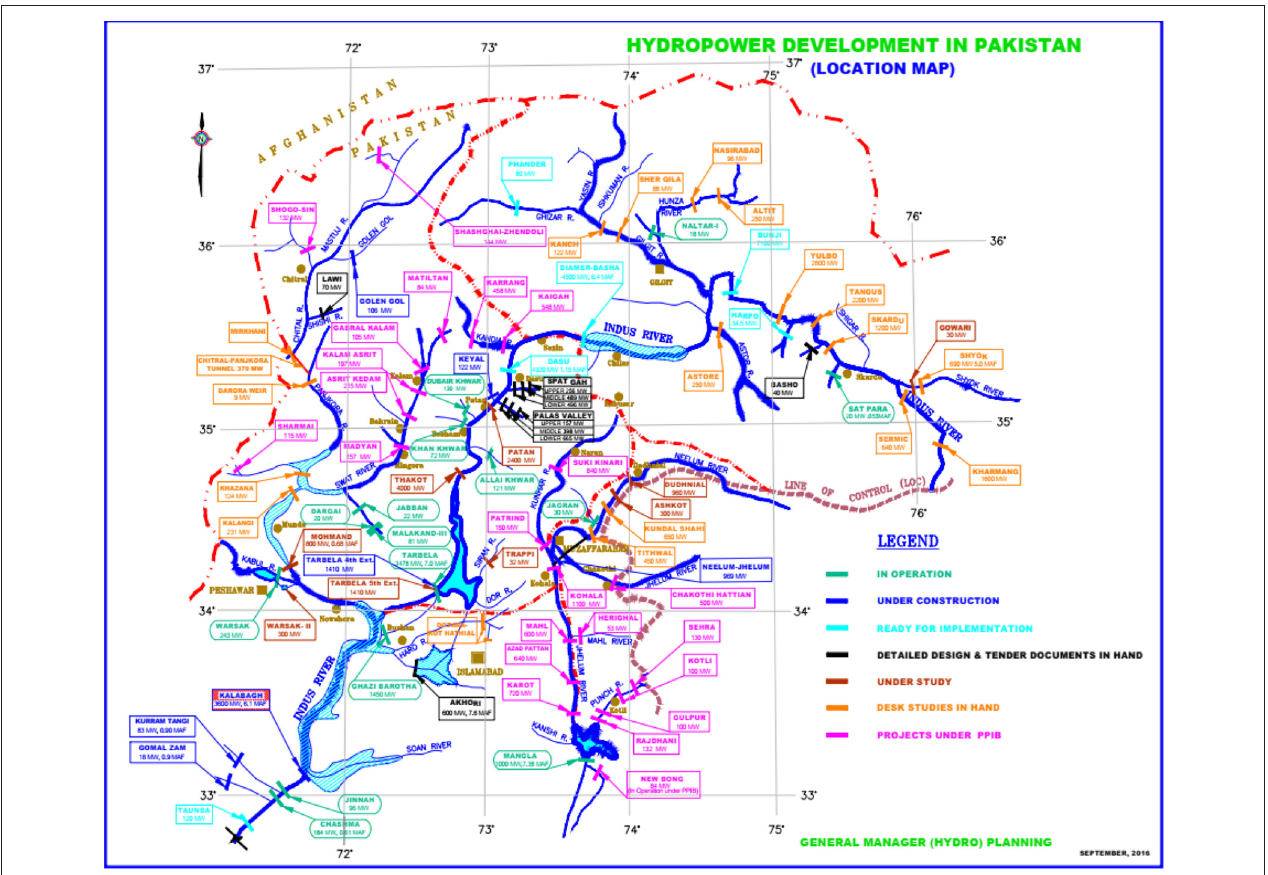
FIGURE 5 | Hydroelectric power development in Pakistan 7